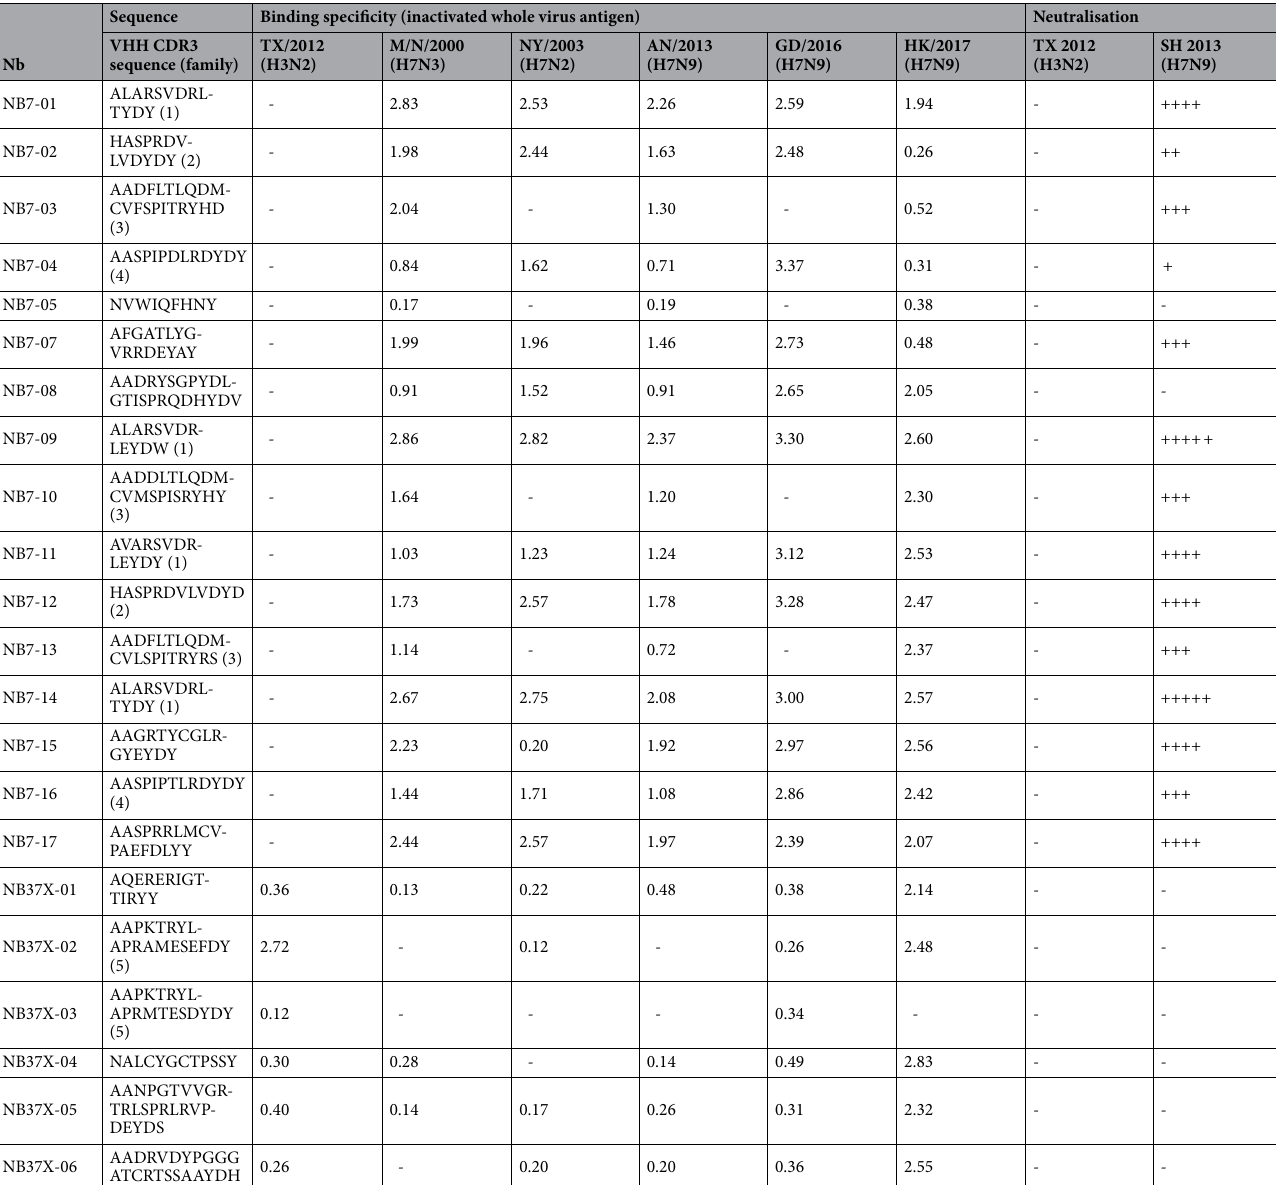
Table 1. Nanobody sequence, specificity and neutralisation activity. VHH-CDR3 sequences and family grouping of related sequences. ELISA is given as the average OD450nm reading of two wells coated with whole virus antigen and Nbs added at a single concentration of 5 µg/ml. – indicates OD450 < 0.1 and represents no binding. Inactivated whole virus antigens used TX/2012(H3N2) [A/Texas/50/2012 (H3N2)], M/N/2000(H7N3) [A/Mallard/Netherlands/12/2000], NY/2003 (H7N2) [A/New York/107/2003], AN/2013 (H7N9) [A/Anhui/01/2013], GD/2016 (H7N9) [A/Guangdong/17SF003/2016], HK/2017 (H7N9) [A/ HongKong/125/2017]. Pseudotype based micro-neutralisation assays using A/Texas/50/2012 (H3) and A/Shanghai/02/2013 (H7) HA bearing pseudoviruses. += 500-3000 nM, ++ < 500 nM, +++< 100 nM, ++++ < 50 nM, +++++< 10 nM, - no